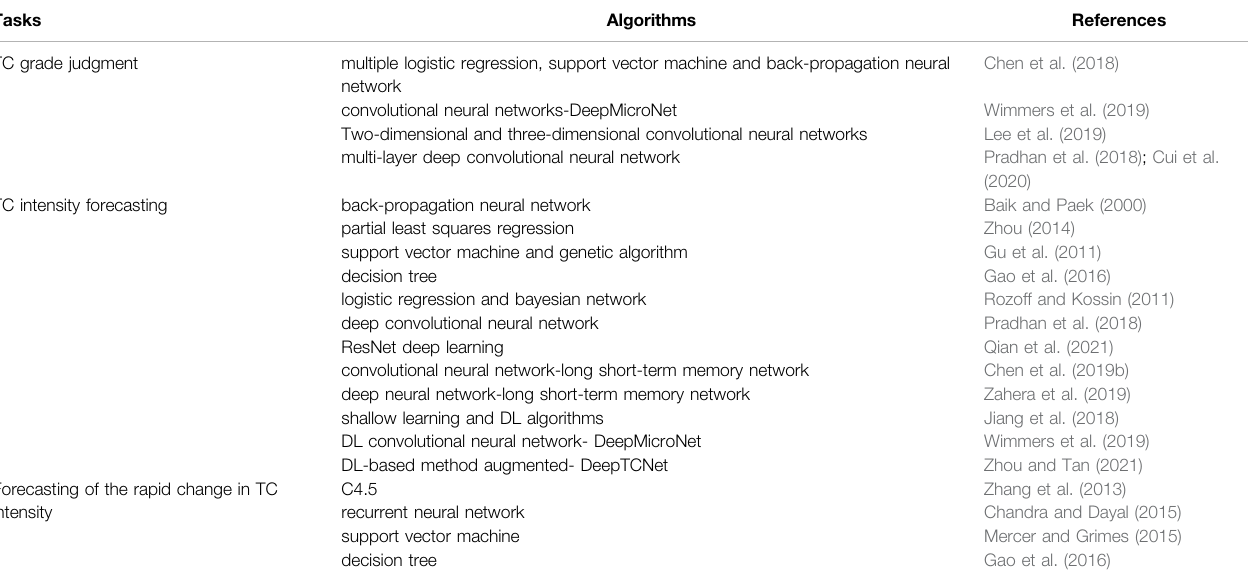
TABLE 3 | Machine learning in TC intensity